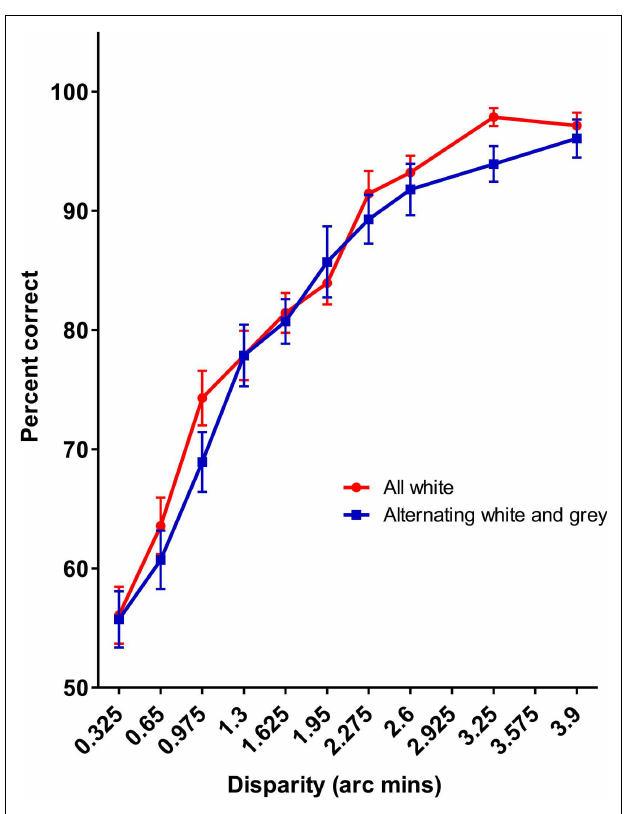
FIGURE 10 |The results of Experiment 3. No difference was observed for the achromatic mixture of amplitudes and the full contrast sinusoidal pattern.